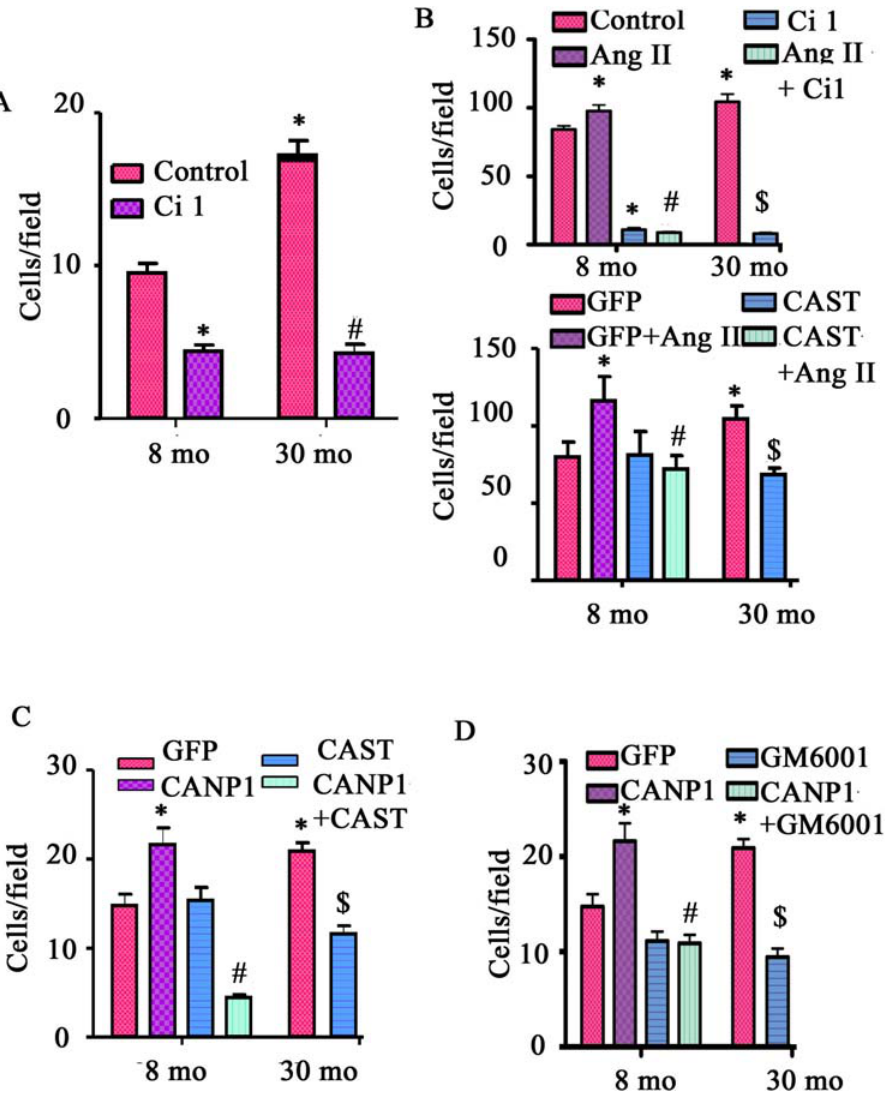
Figure 7. VSMC migration. A. The random migration of VSMC. *p , 0.05, vs. young; and # p , 0.05, vs. young or old untreated control cells B. The migration of VSMC treated with Ang II or Ci1 (upper panel) or infected with or without a CAST virus (lower panel), in response to a PDGF-BB gradient (10ng/ml) *p , 0.05, vs. young untreated VSMC (control). # p , 0.05, vs. Ang II treated young VSMC. $p , 0.05, vs. old untreated VSMC. C. The random migration of VSMC infected with a CANP1 or CAST virus. *p , 0.05, vs. young; and # p , 0.05, vs. young infected with CANP1 virus. $p , 0.05 vs. old infected with control (GFP) virus. D. The random migration of VSMC infected with CANP1 or GM6001. *p , 0.05, vs. young; and # p , 0.05, vs. young infected with CANP1 virus. $p , 0.05 vs. old infected with control (GFP)